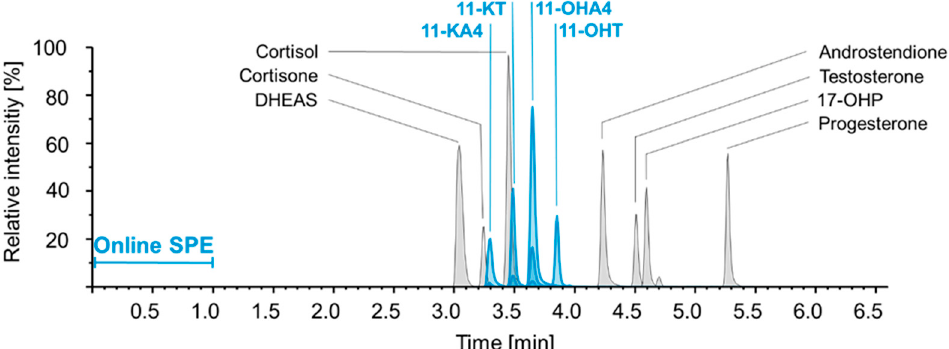
Figure 2. Exemplary chromatogram for single shot analysis of 11 steroid hormones. Chromatographic separation with retention times and relative intensities of 11-OAs (blue; 11-KA4, 11-KT, 11-OHA4 and 11-OHT) and established steroid panel (grey; 17-OHP, androstenedione, cortisol, cortisone, DHEAS, testosterone and progesterone) [34]. 11-KA4, 11-ketoandrostenedione; 11-KT, 11-ketotestosterone; 11-OHA4, 11 β -hydroxyandrostenedione; 11-OHT, 11 β -hydroxytestosterone; 17-OHP, 17 α -hydroxyprogesterone; DHEAS, dehydroepiandrosterone sulfate; SPE, solid phase extraction. Inter- and intra-assay coefficients of variation (CVs) in spiked serum and spiked controls were between 2% and 13% for 11-KA4, 2% and 15% for 11-KT, 2% and 7% for 11-OHA4, 2% and 10% for 11-OHT. Mean recovery ranges in spiked serum and spiked controls were between 102% and 115% for 11-KA4, 85% and 105% for 11-KT, 100% and 114% for 11-OHA4 and 99% and 117% for 11-OHT (Table 1). Lower limits of quantification (LLOQs) were determined at 63 pmol/L for 11-KA4 (CV 20%, s/n = 13), 100 pmol/L for 11-KT (CV 9%, s/n = 17), 320 pmol/L for 11-OHA4 (CV 3.9%, s/n = 30) and 83 pmol/L for 11-OHT (CV 5.7%, s/n = 13). In freeze/thaw stability experiments, the concentrations of 11-OAs were stable across five cycles with a reproducibility within the acceptable limit of 20% and without increasing or decreasing trend (Figure 3). Table 1. Inter-assay imprecision and recovery of 11-oxygenated androgens. Means and coefficients of variation for spiked serum and quality controls at low, moderate and high concentration levels. 11-KA4